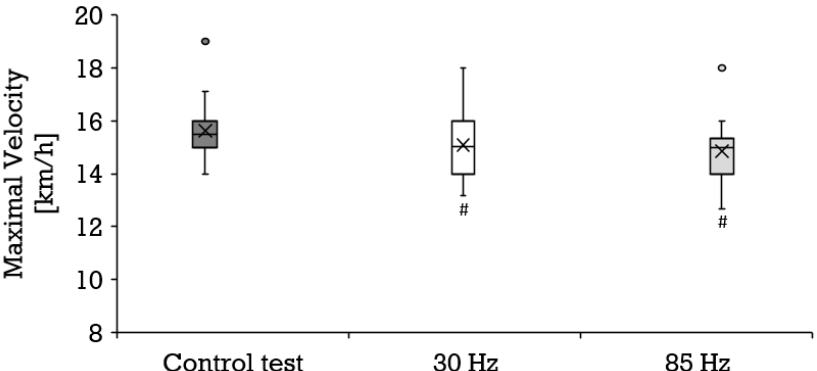
Figure 5. Distribution of the maximal velocity (km/h) depicted as boxplot during the control test (dark gray box, n = 22), running with 30 Hz (white box, n = 22) and running with 85 Hz (bright grey box, n = 22). Each filled circle is representing a discordant value. Significances ( p < 0.05) compared to the control test are labeled with